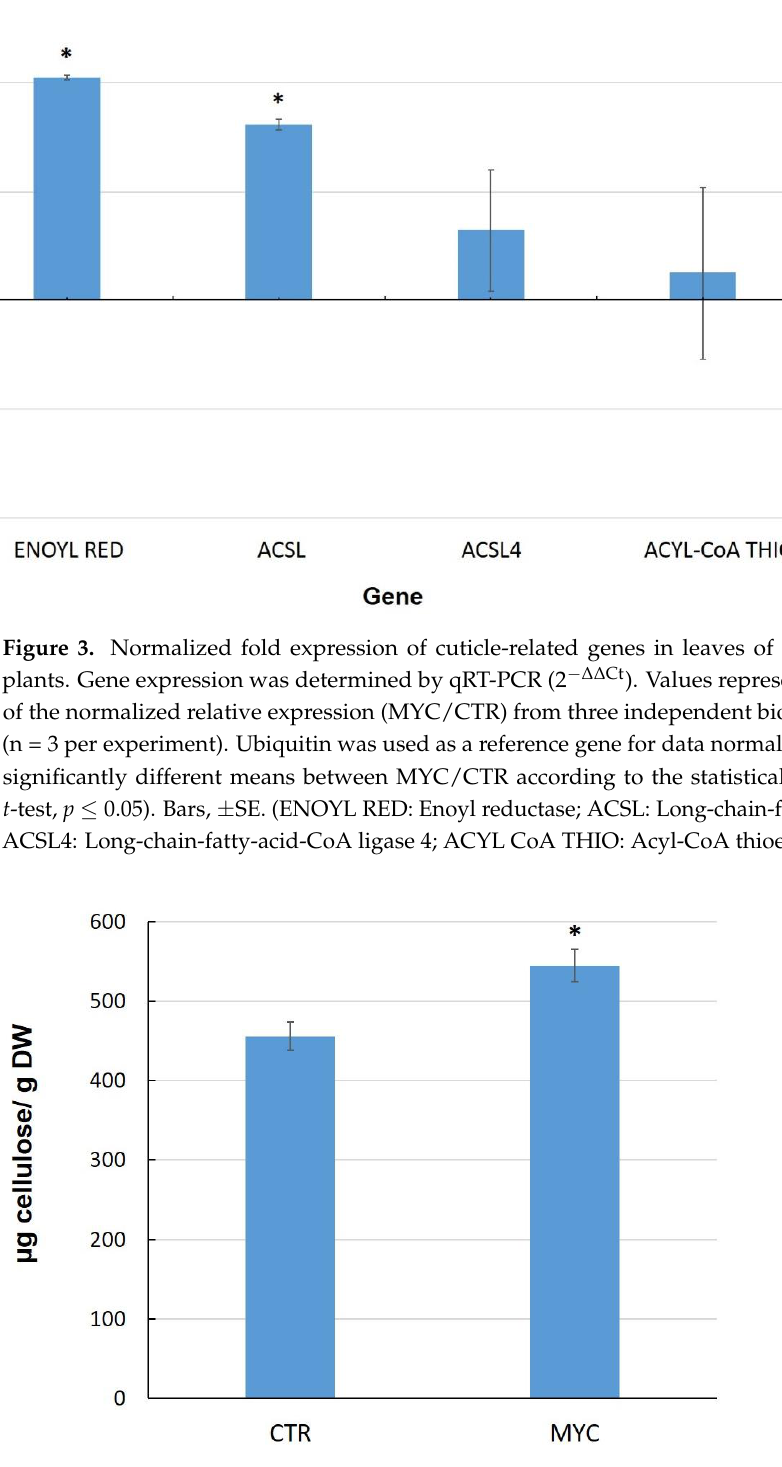
Figure 4. Cellulose content in leaves of MYC and CTR tomato plants. Values represent the average from two independent biological experiments (n = 5 per experiment). (*) represent significantly different means between MYC/CTR according to the statistical analysis (Student’s t -test, p ≤ 0.05). Bars, ±